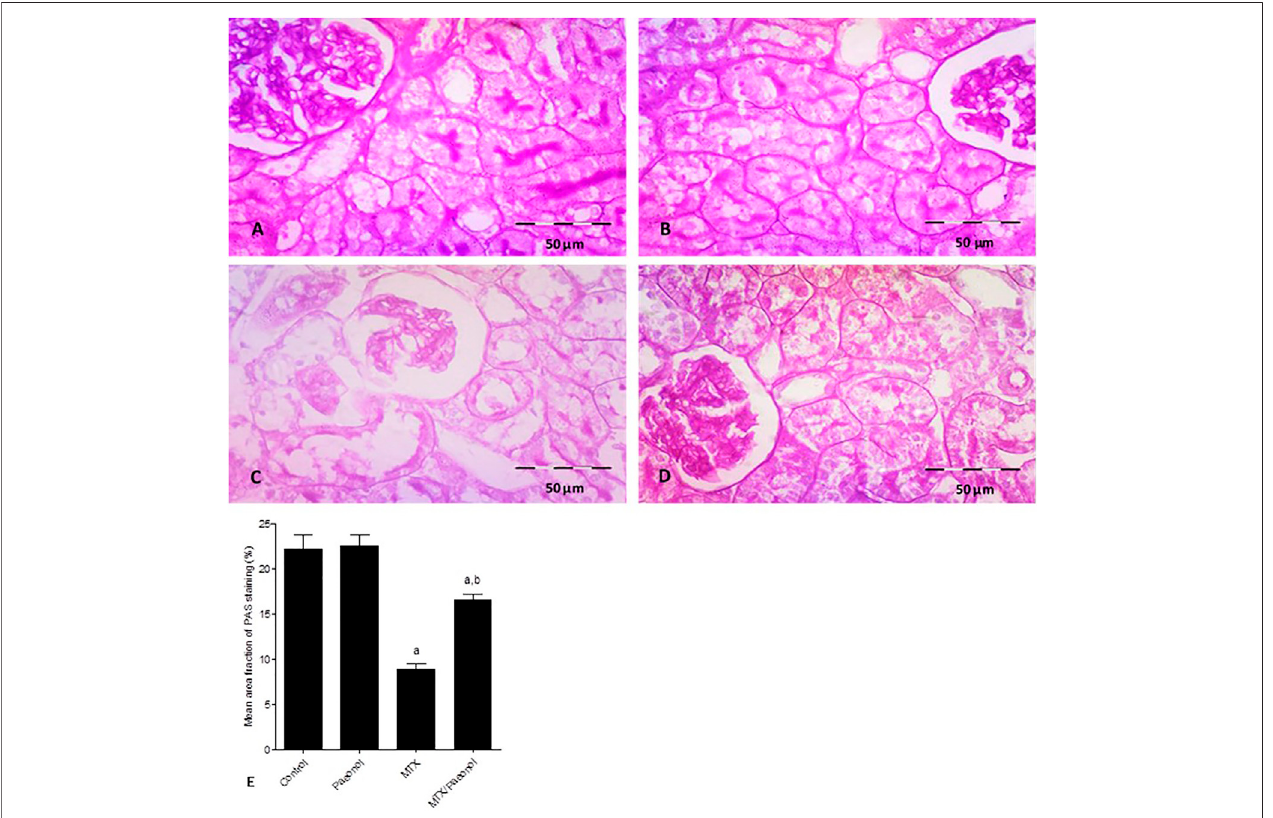
FIGURE 2 | Histopathological picture of the kidney after methotrexate (MTX) and/or paeonol administration stained by periodic acid – Schiff (PAS). A photomicrograph of the rat kidney (×400) obtained from (A) control, (B) paeonol-treated, (C) MTX-treated, and (D) MTX/paeonol-treated rats. (E) Percent of mean area fractionofPASstainingobtainedfromsectionsofeachanimal( n =6foreachgroup),six fi elds/section,whereresultswereconsideredsigni fi cantlydifferentwhen p < .05. a,b Signi fi cant difference compared to control or MTX groups,